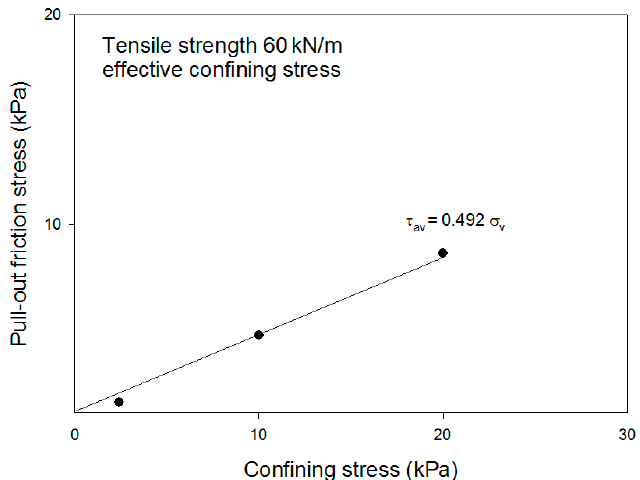
Figure 9. Relationship curve between confining stress and pullout frictional stress by effective confining stress (T g = 60 kN/m).